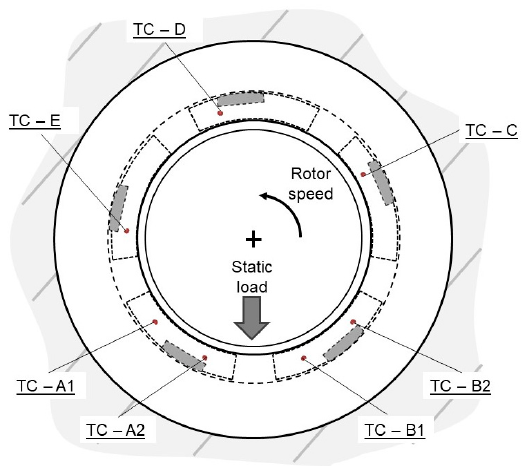
Figure 8. Flooded Rocker Pivot bearing with thermocouples position.